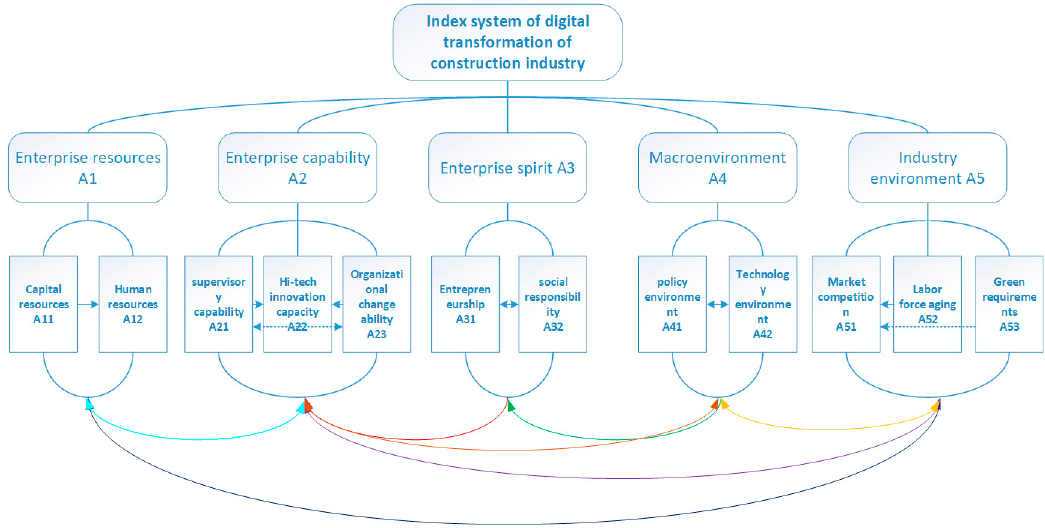
Figure 5. The ANP network structure.